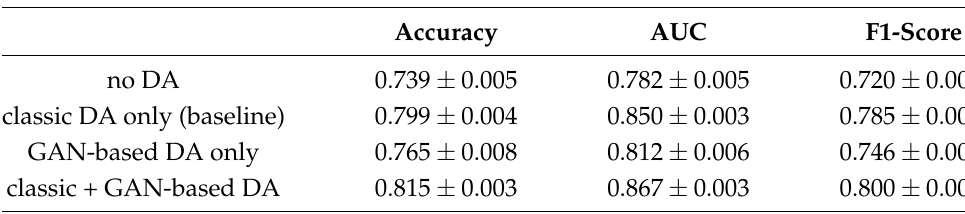
Table 4. Comparison of baseline classifier without and with different strategies of data augmentation (classical and GAN-based using ψ = 1, R a = 6, ResNet18_128x128 , 5